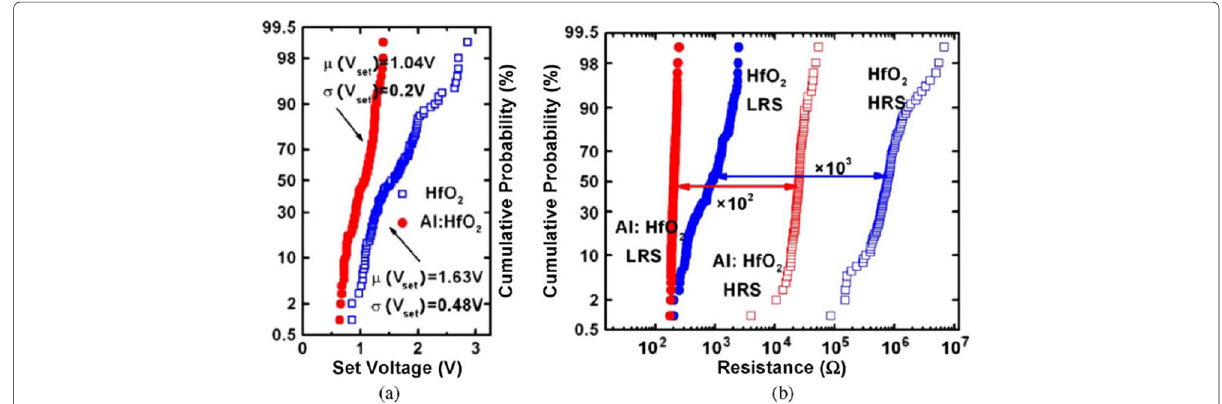
Fig. 8 Uniformity improvement of Al buffered HfO x RRAM compared to HfO x -based RRAM array. a Statistical distribution of SET voltage ( V set ) obtained from 100 DC sweep cycles. b HRS and LRS statistical distribution for 100 pulse sweep cycles; reprinted from ref.